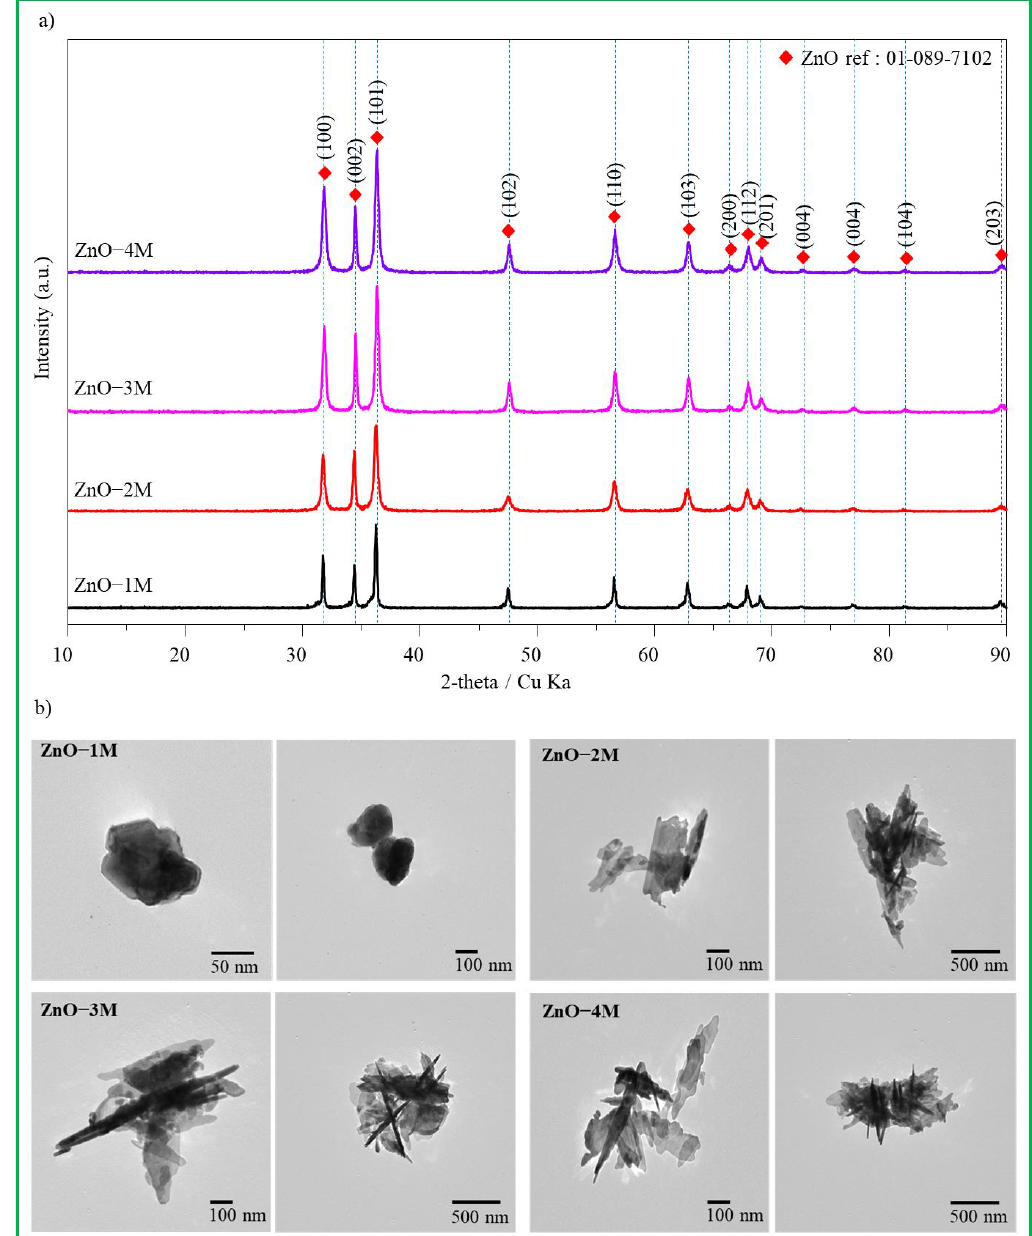
Figure 1. ( a ) XRD patterns of synthesized ZnO particles. ( b ) TEM images of synthesized ZnO particles ( ZnO− 1M, ZnO− 2M, ZnO− 3M and ZnO− 4M) at two different magnifications. In the TEM image in Figure 1b, the particle shape of ZnO− 1M synthesized in the presence of 1.0 M NaOH was nearly circular shape. This implies that the Na + ions of NaOH did not act as a capping agent and hydrolysis occurred in all axial directions, similar to the x-, y-, and z-axes, and crystals were grown. However, it can be assumed that from the needle-shaped ZnO nanomaterials obtained in the 2.0 M NaOH solution, Na + ions acted as a capping agent, bound with the x- or y-axis of Zn, and interfered with the hydrolysis process. Moreover, as the NaOH concentration increased further, the needle thickness also increased and the particle grew into a rod shape. In particular, sheet-type ZnO was found to coexist. This image shows that in the presence of a strong alkaline solution, ZnO nano- materials partially dissolve in a strong base, spread similar to a sheet, and finally grow into rods while winding the needle shaped ZnO core [33].